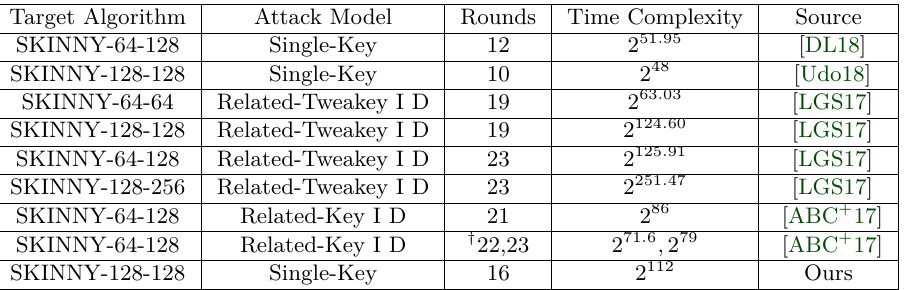
Table 1: Summary of the Attacks on